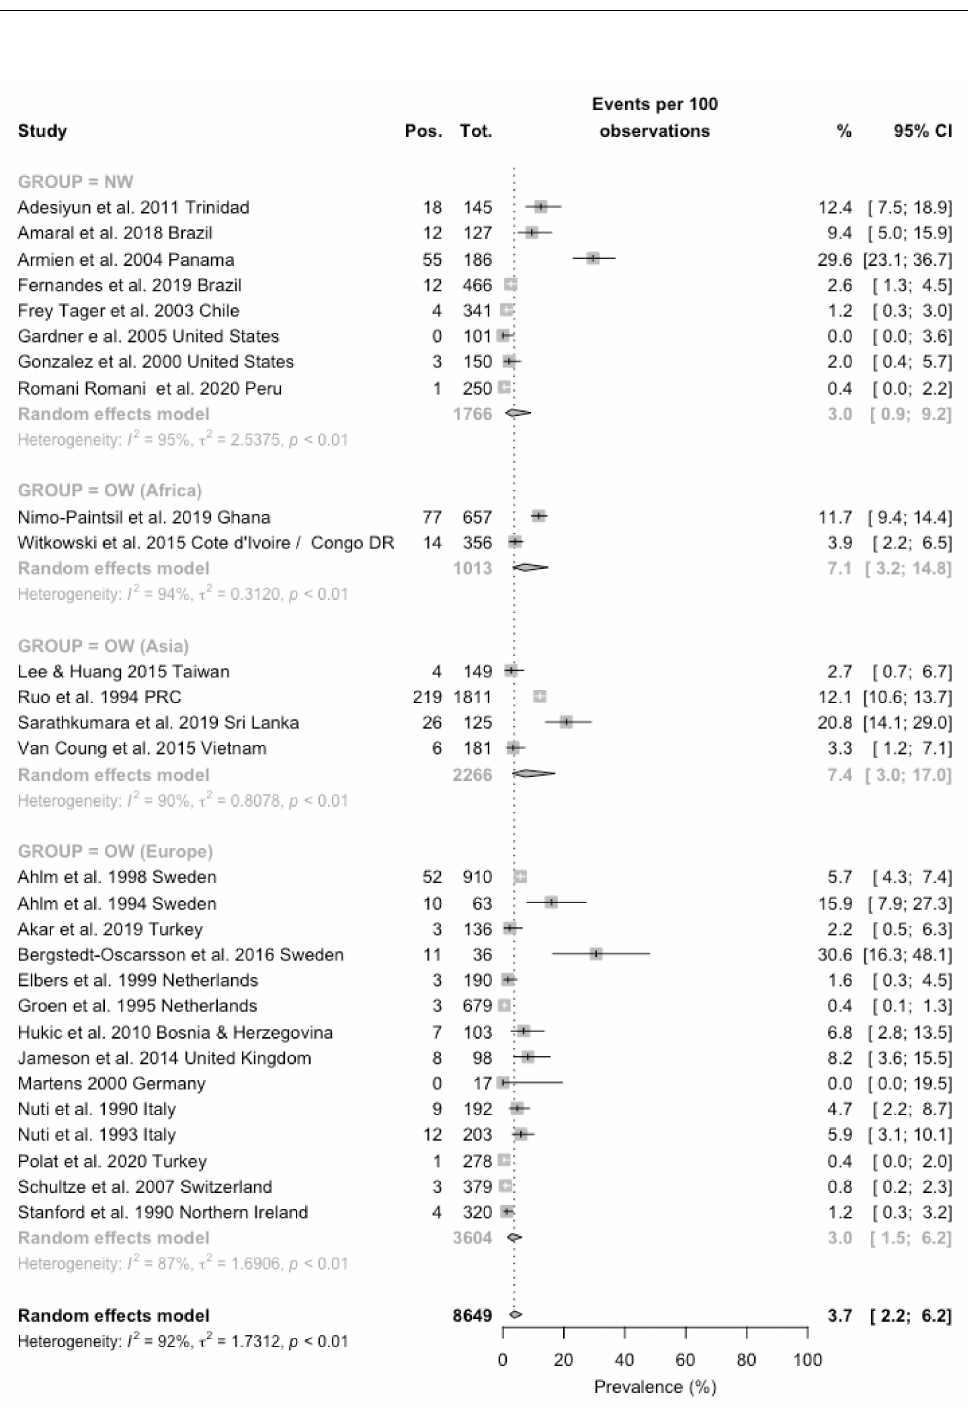
Figure 2. Forest plot representing the estimated pooled prevalence for seropositive status for han- taviruses among agricultural workers. Pooled prevalence rate was estimated in 3.7% (95% CI 2.2–6.2), with estimates that were considerably greater in studies performed in Asian countries (7.4%, 95% CI 3.0–17.0), followed by African countries (7.1%, 95% CI 3.2–14.8), European (3.0%, 95% CI 1.5–6.2) and American countries (3.0%, 95% CI 0.9–9.2). Notes: OW = Old World (i.e., Eurasia and Africa); NW = New World (North and Central/South